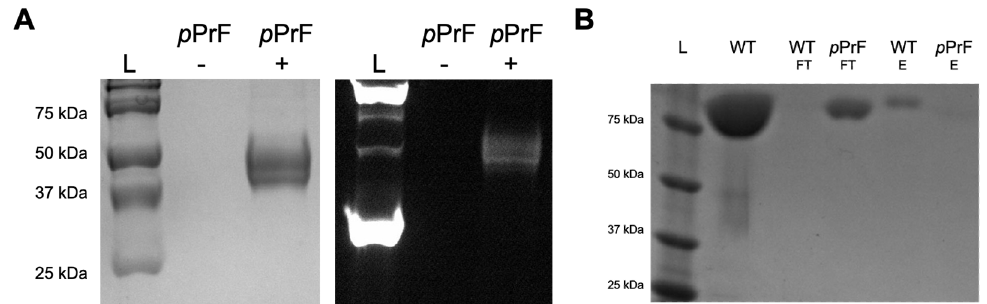
Figure 3. Methodology validation of UTAG expression with p PrF ncAA. ( A ) Initial attempts at expression of the Sc Y147TAG mutant. Similar results were observed with all mutation sites in both Sc and Km expressions. While full-length expressed protein was expected around 84 kDa, a significantly shorter protein of ~40 kDa was produced (Coomassie stain gel on left). The expression did appear to contain p PrF as no protein product was observed in the absence of p PrF addition ( − ), but protein was detected with the addition of the ncAA (+). Incorporation of the ncAA was further confirmed as the sample was also subjected to Glaser–Hay bioconjugation with AlexaFluor-488, resulting in the covalent modification of the protein and a fluorescent band (right gel; +lane). L = protein ladder. ( B ) Following modification of expression conditions, full-length UTAG was produced that harbored the p PrF ncAA. The protein was then assayed for SUMO binding with a pull-down bead-based assay. Both the flow-through (FT) and elution (E) of the assay were observed by SDS-PAGE. For the wild-type protein, very little protein was observed in the flow-through (WT-FT), suggesting SUMO binding, which was confirmed by the presence of UTAG in the elution (WT-E). In the case of the Km Y576TAG mutant (and all other mutants), the UTAG protein was only observed in the flow-through ( p PrF-FT) and not in the elution ( p PrF-E). L = protein ladder; WT = wild-type control.